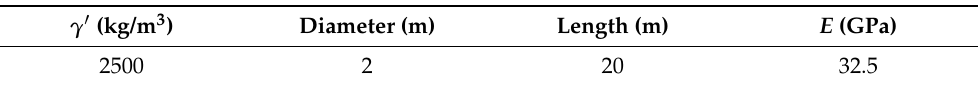
Table 2. Parameters of pile.